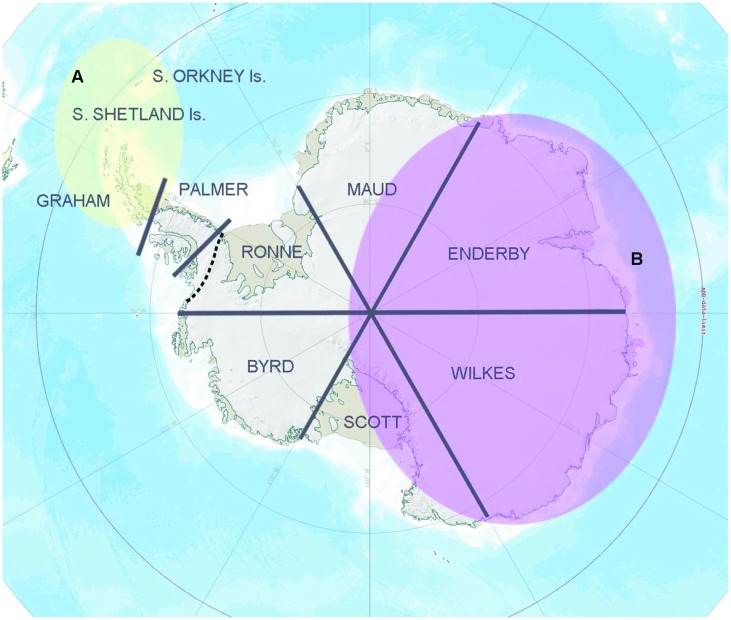
Regional bacterial biogeography pattern based on the 16S rRNA gene data information. A strong genetic separation was detected in the overall soil bacterial community composition and Bacteroidetes assemblages retrieved between zone A (yellow) and zone B (purple; Chong et al., 2012b), representing different sides of the “Gressitt Line” (dotted line). A similar pattern was observed in bacterial isolates affiliated with the genera Flavobacterium and Arthrobacter (Chong et al., 2013).